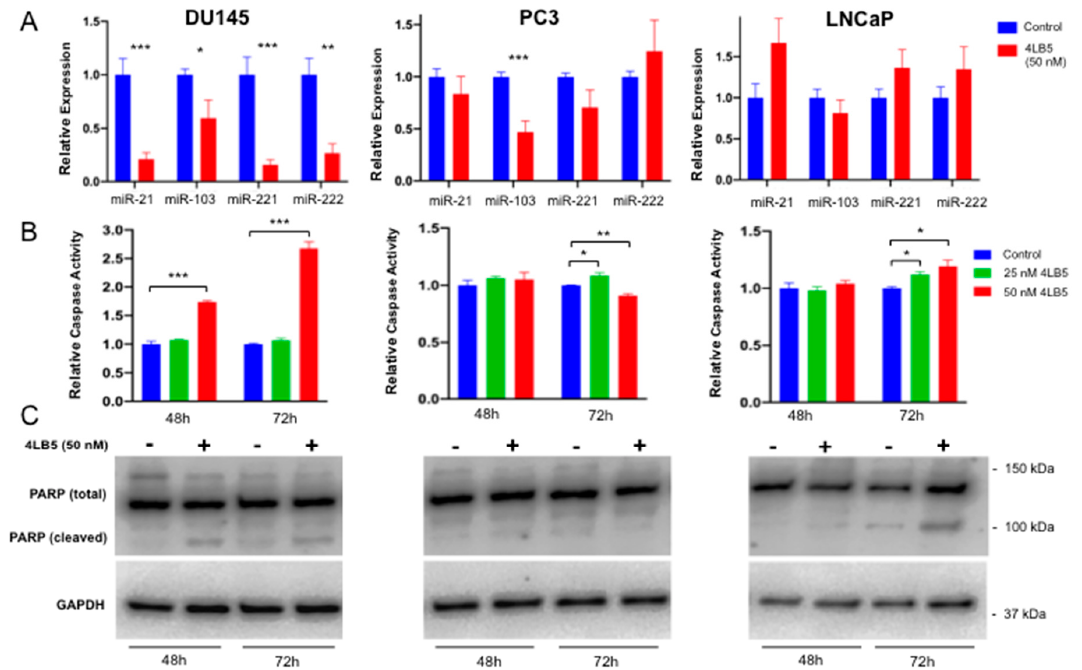
Figure 3. Treatment with 4LB5 Reduces Mature Forms of Oncogenic MicroRNAs and alters cell survival ( A ) microRNA expression levels were assessed via qRT-PCR in DU145, PC3, and LNCaP cells after 48 h treatment with 50 nM 4LB5 or control solution. qRT-PCR data are the average of three independent experiments performed in at least technical duplicate. ( B ) Caspase 3/7 activity was assessed after 48 and 72 h of 4LB5 treatment. Caspase assay was performed in biological triplicate for each time point and averaged. ( C ) PARP cleavage was assessed by Western blot after PCa cell treatment with 4LB5 or control solution for 48 and 72 h. PARP Western blots are representative of at least two independent experiments. Student’s t-test (2-tailed, homoscedastic) was utilized for statistical analysis. Uncropped blots of Figure 3C are shown in Figure S4. * p < 0.05, ** p < 0.01, *** p < 0.001, **** p < 0.0001.